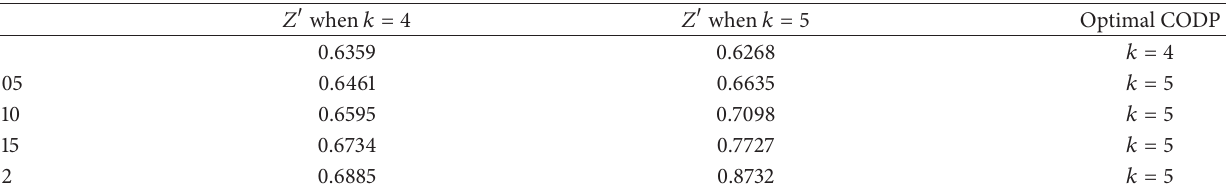
Table 8: The results of 𝑍 󸀠 varied with 𝜌 ( 𝑅 = 3 ).